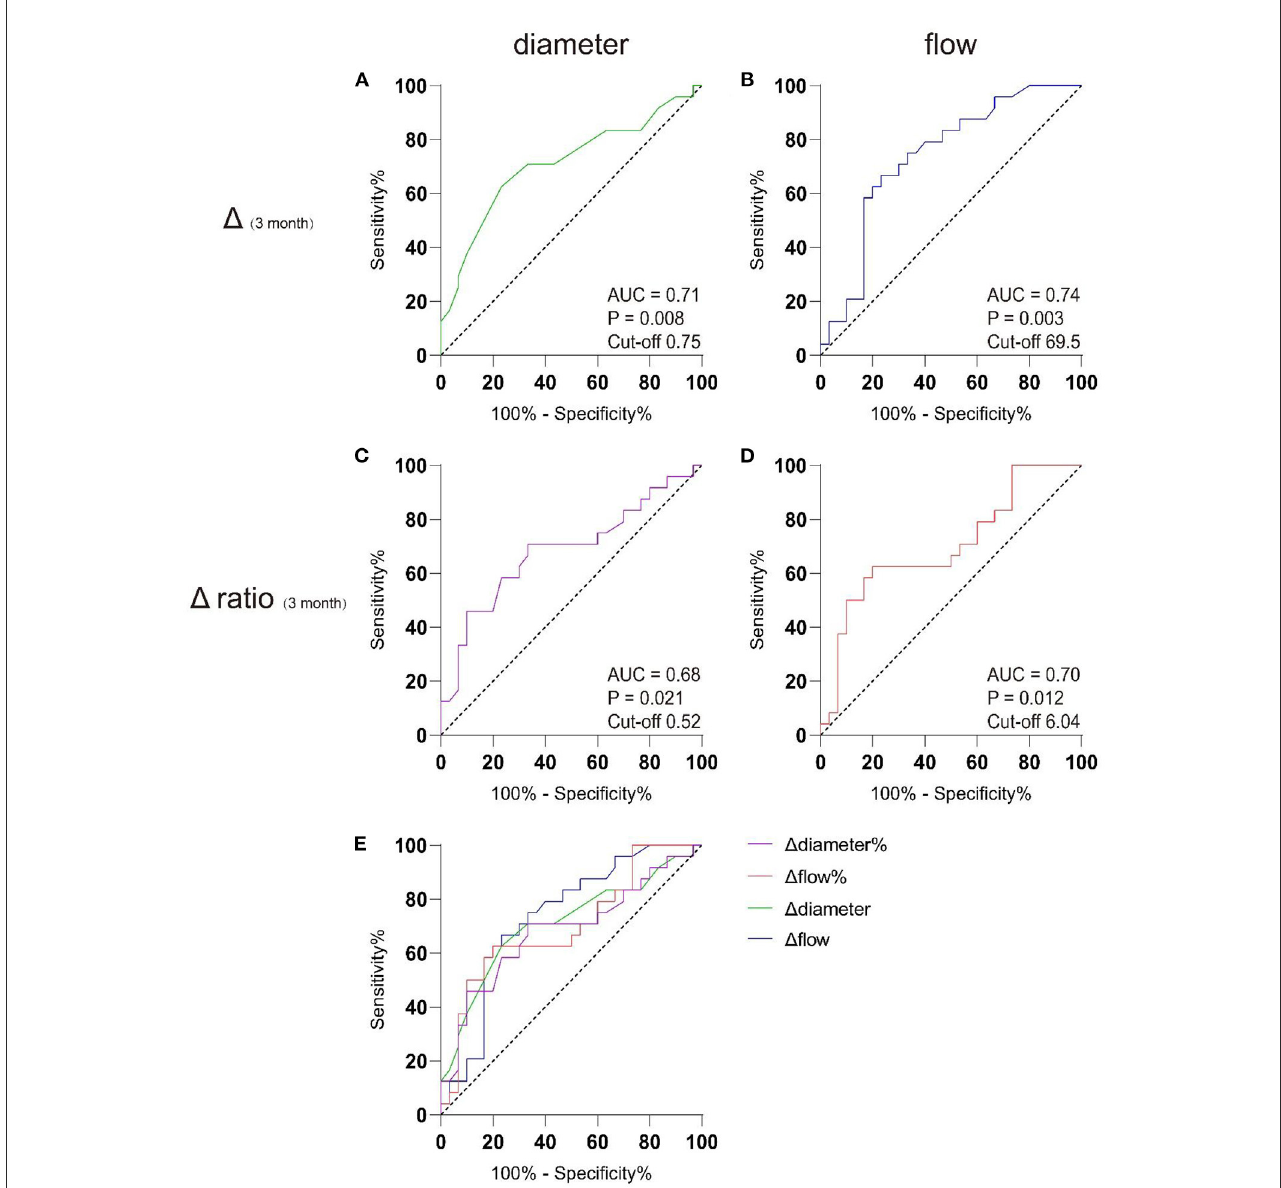
FIGURE3 AUC analysis of receiver-operating characteristics. Preoperative data were used as baseline to discriminating well-compensated collateral group (W group) from poor-compensated collateral group (P group) in post-operative 3 month by receiver operating characteristic (ROC) analysis. (A) The cut-off value for the widened diameter of the STA graft was 0.75mm, with the AUC of 0.71. (B) The cut-off value for the increased flow of the STA graft was 69.5 ml/min, with area under curve (AUC) of 0.74; (C) The cut-off value for the widened diameter ratio of the STA graft was 52%, with the AUC of 0.68; (D) The cut-off value for the increased flow ratio of the STA graft was 604%, with area under curve (AUC) of 0.70. (E) The comparison between the 4